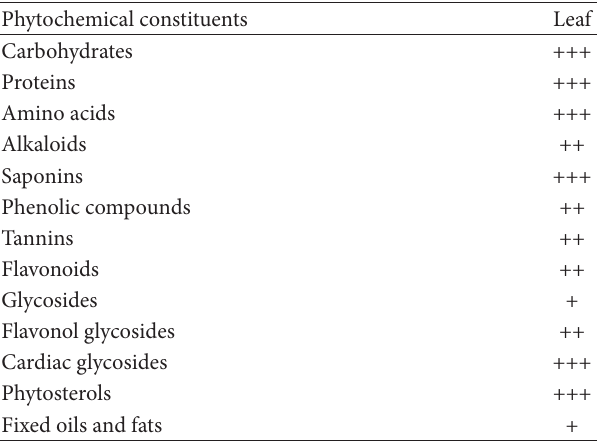
Table 1: Phytochemical screening of C. dipsaceus